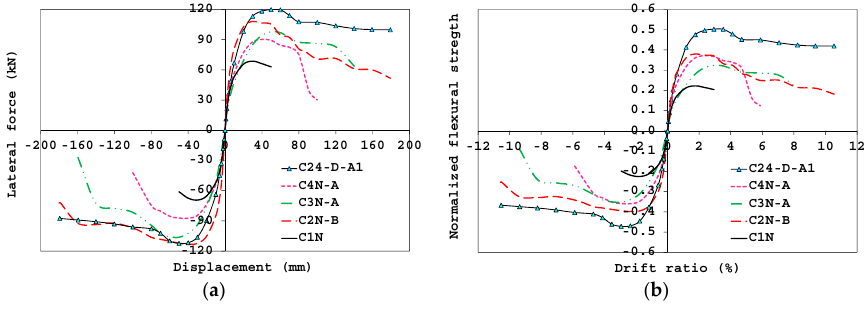
Figure 9. F ‒Δ envelopes ( a ) and μ‒δ envelopes ( b ) under ν = 0.40. Figure 9. F - ∆ envelopes ( a ) and µ - δ envelopes ( b ) under ν = 0.40.